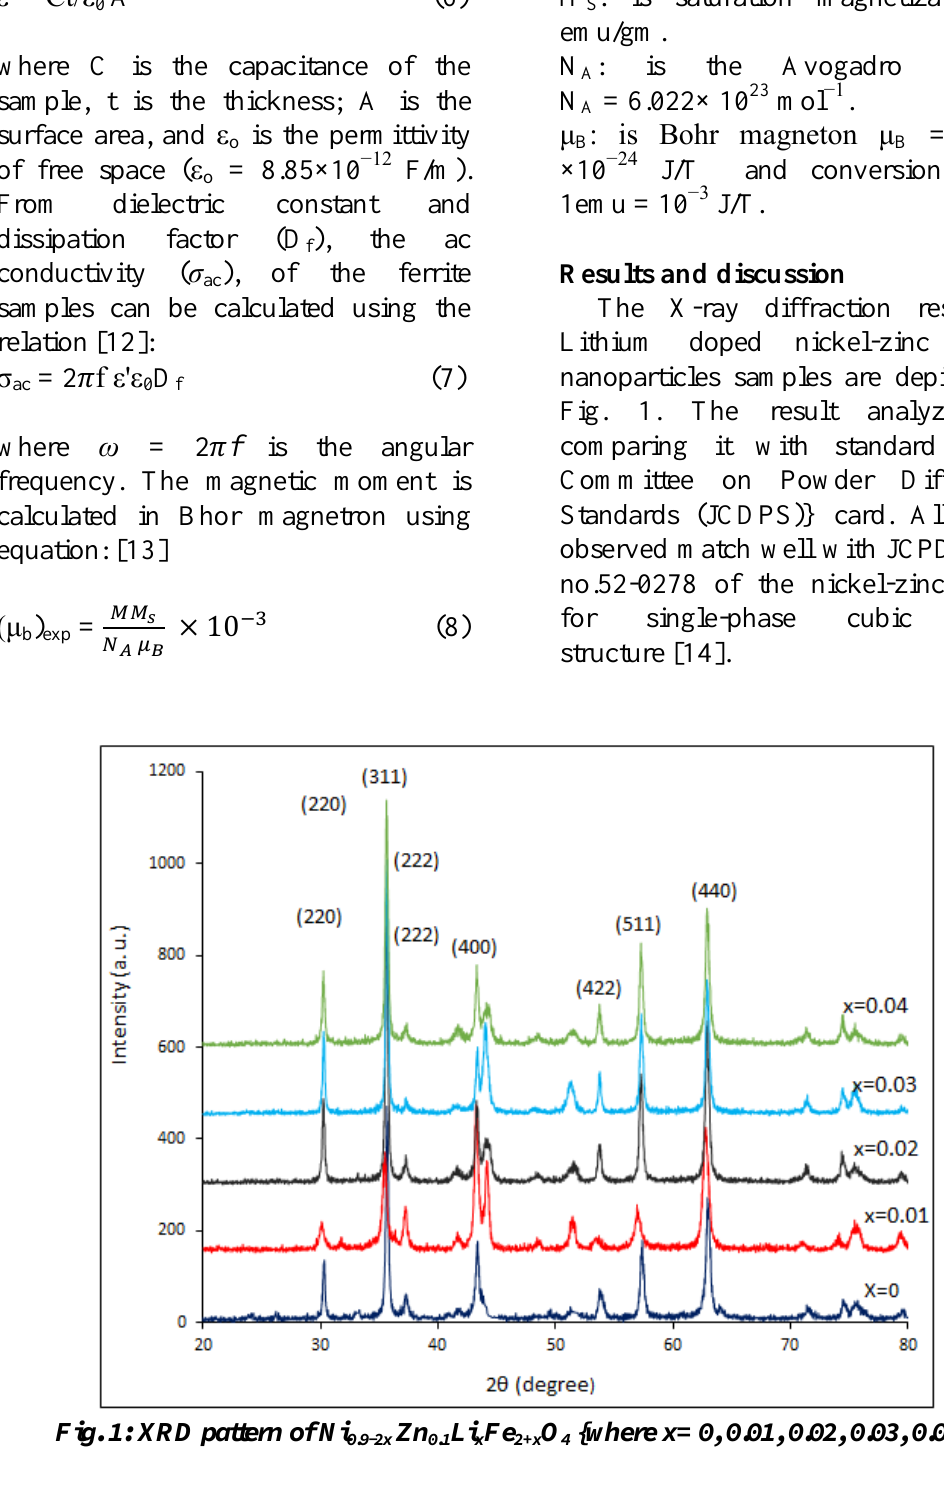
Fig. 1: XRD pattern of Ni